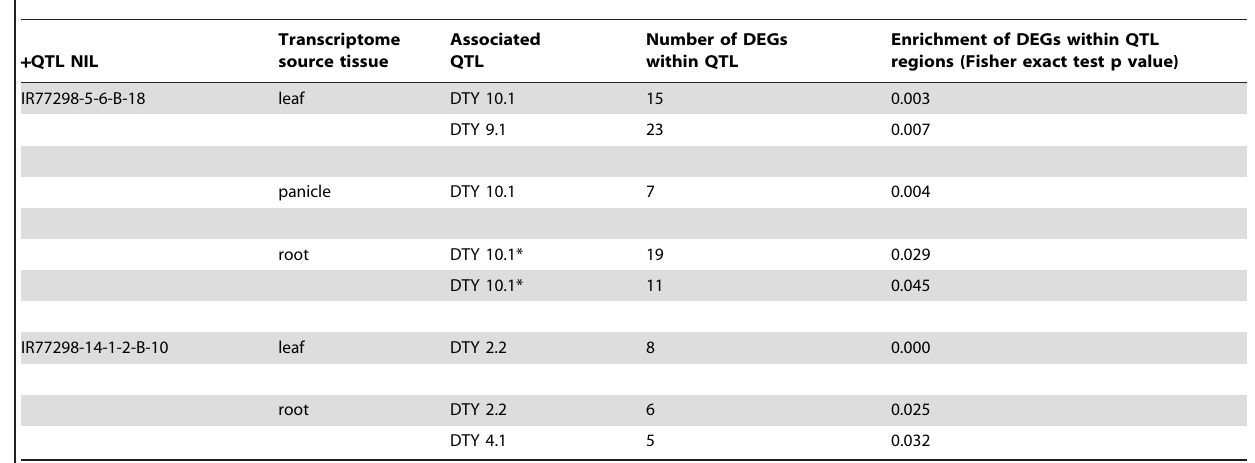
Table 3. Number of differentially expressed genes in + QTL and –QTL lines under two drought stress conditions.